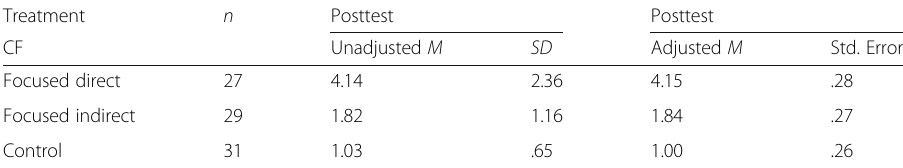
Table 11 Descriptive statistics for the metalinguistic knowledge test Treatment n Posttest Posttest CF Unadjusted M Focused direct